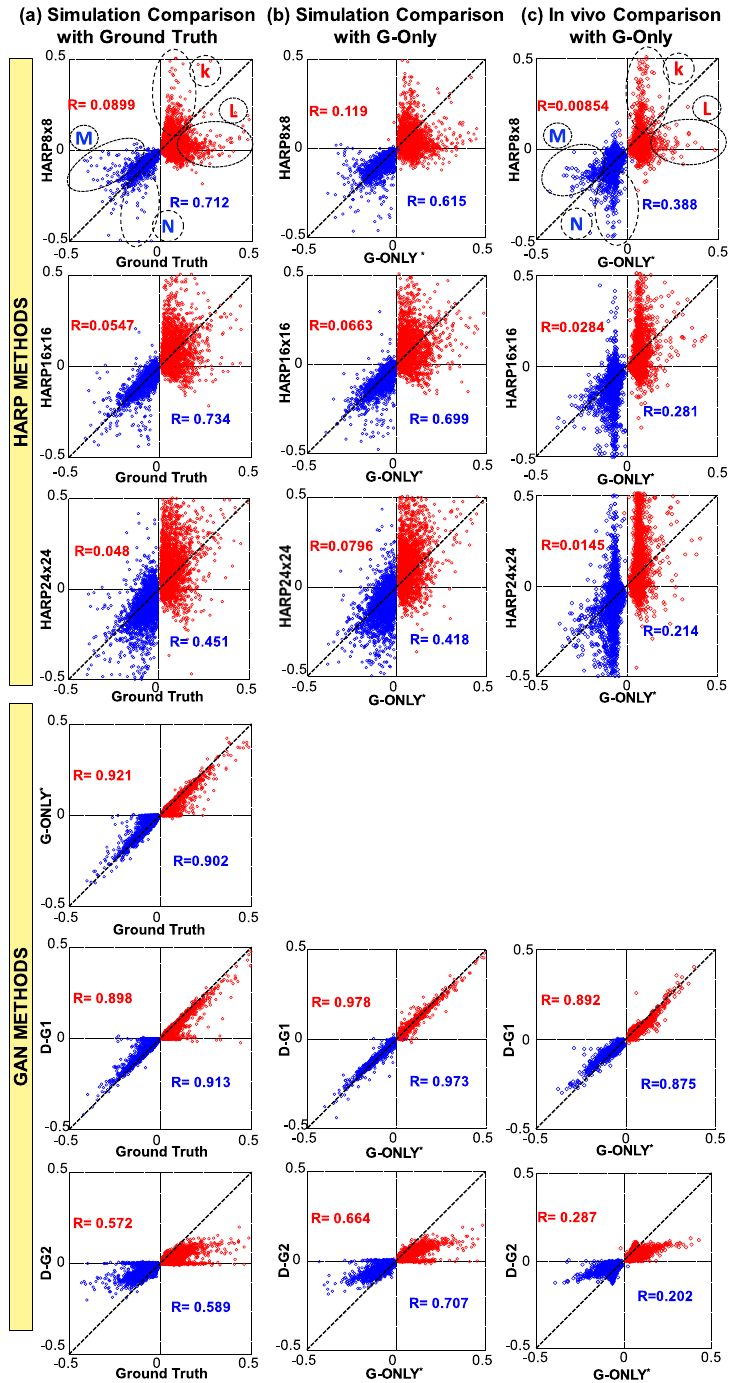
Figure 7. Scatter plot comparisons between various HARP and the proposed GAN-based methods. The first and second principal strains ( ε p 1 and ε p 2 ) are represented by the red and blue points, respectively. The farther the points deviate coherently from the 45° diagonal identity line, the more the technique over- or under- estimates strain values. K and N regions (dotted elliptic shapes) represent HARP overestimation of ε p 1 and ε p 2 , respectively, relative to the reference ground-truth strains, whereas L and M represent the corresponding overestimation zones. The comparisons between the different techniques and the ground-truth values for the simulated dataset are shown in ( a ). The comparisons with the G-Only technique for the simulated datasets are shown in ( b ). Finally, the comparisons with the G-Only technique for in-vivo datasets are displayed in panel ( c